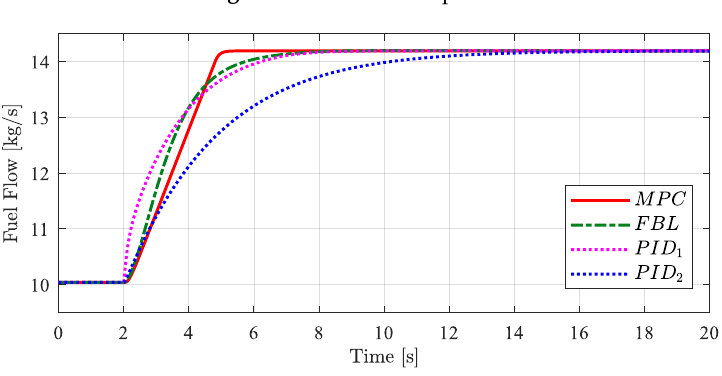
Figure 8. Air flow time profile.